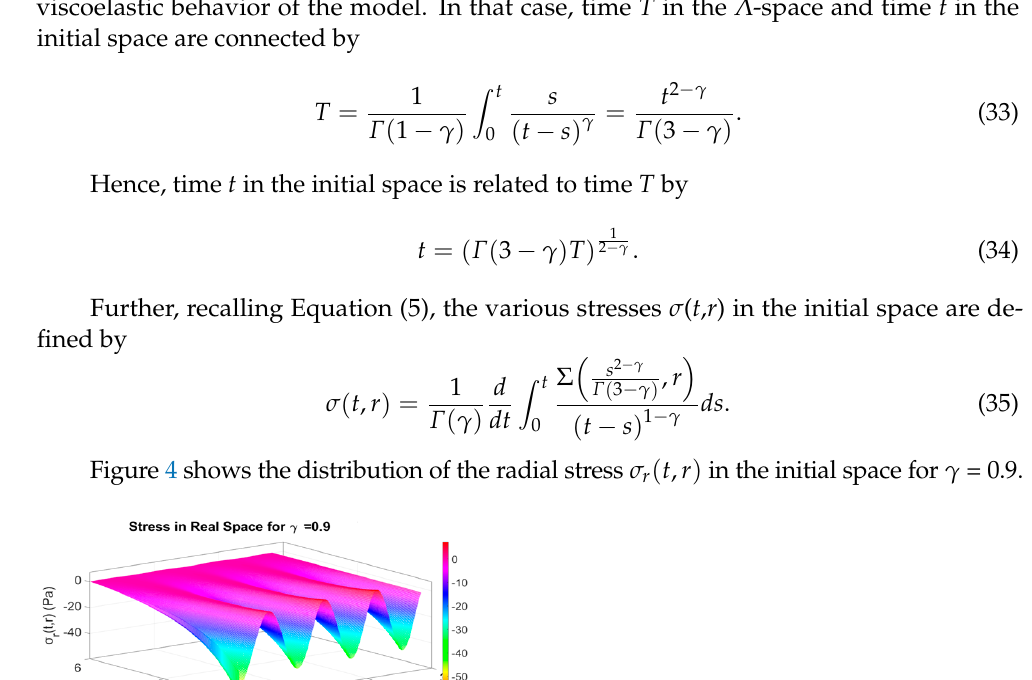
Figure 3. The stress Σ θ ( T , R ) in the Λ -fractional space.